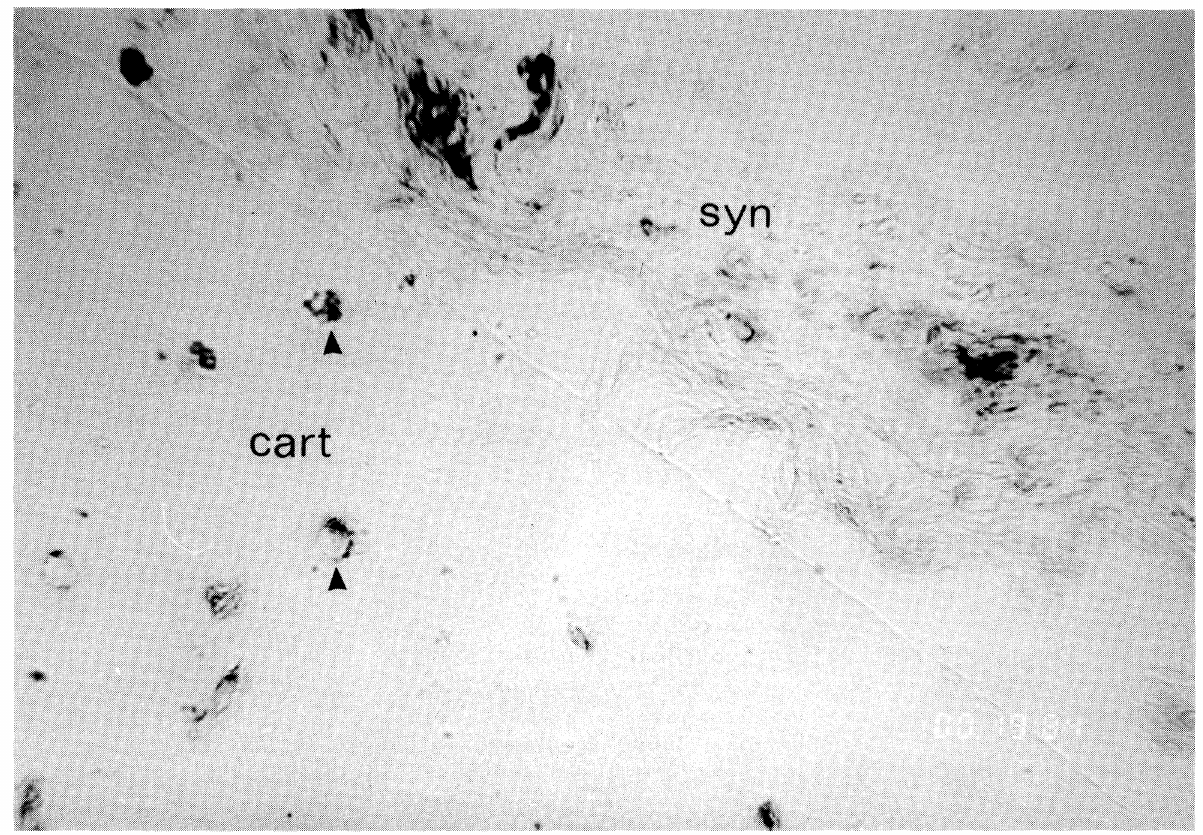
FIG. 2. Co-culture of normal human cartilage with inflammatory rheumatoid synovium. Note the expression of ICAM-1 on chondrocytes (arrows) and on synovial cells, syn, synovium" cart, articular cartilage.